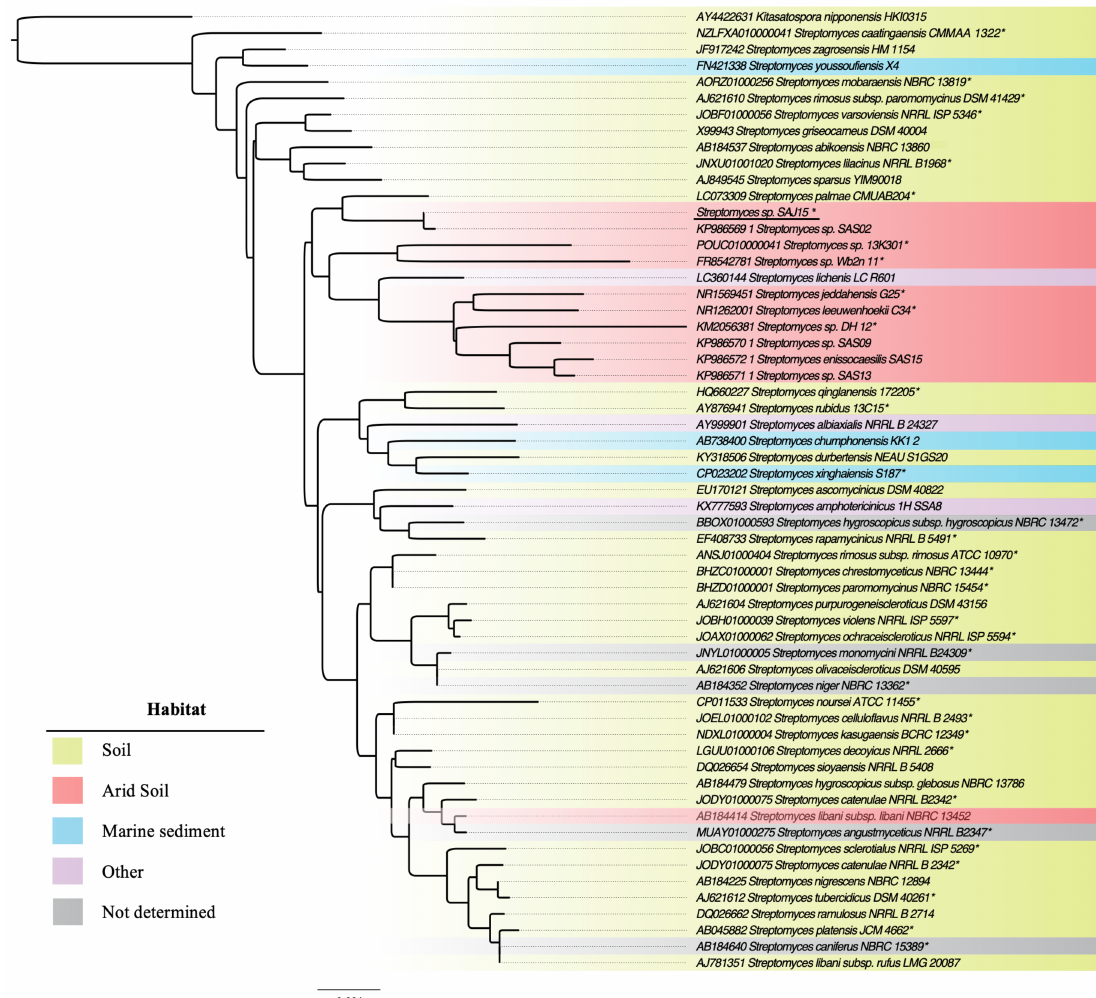
Figure 1. Streptomyces phylogenetic tree based on 16S rRNA gene sequence. SAJ15 forms a monophyletic clade with the desert isolate SAS02. Most of the Streptomyces isolated from arid-soil form a clade taxonomically near to SAJ15. Kitasatospora nipponensis HKI 0315 was used as an outgroup. Habitats for each Streptomyces isolates are indicated with colored bullets. Genome assembly availability is marked with an